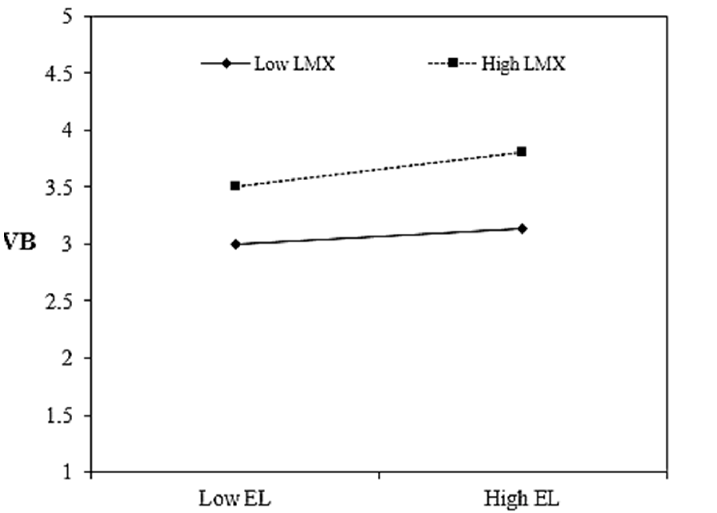
Figure 2. Direct effect interaction. Note: EL = ethical leadership, LMX = leader–member exchange, PS = psychological safety, VB = voice behavior.